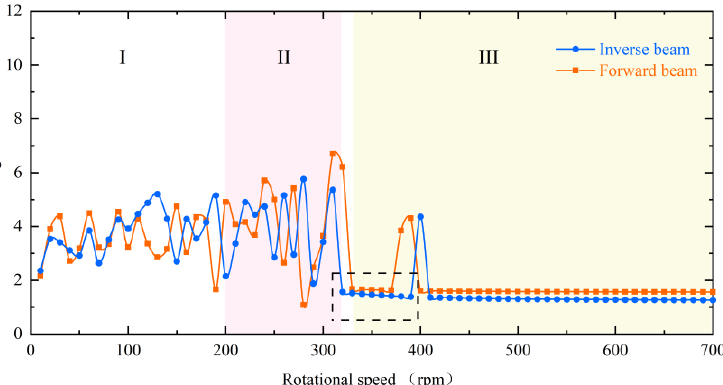
Figure 14. Simulation results of magnet spacing of 8 mm (blue line) and 10 mm (red line) at 400 rpm (20 Hz) in frequency down-conversion mechanism, ( a , d ) are the corresponding measured displacements, ( b , e ) are the corresponding measured output voltages, and ( c , f ) are the corresponding power spectrums.